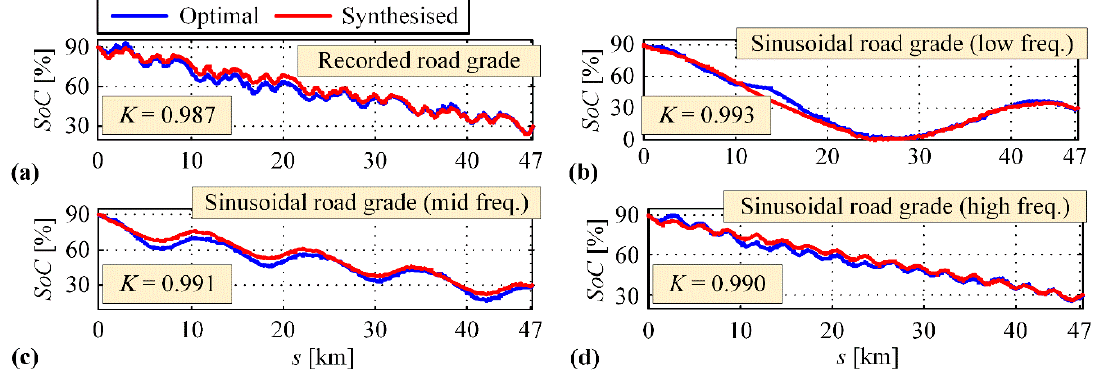
Figure 13. ( a ) Synthesized SoC reference trajectories plotted along with DP-optimal trajectories for recorded road grade profile and ( b–d ) sinusoidal profiles with different spatial frequencies.